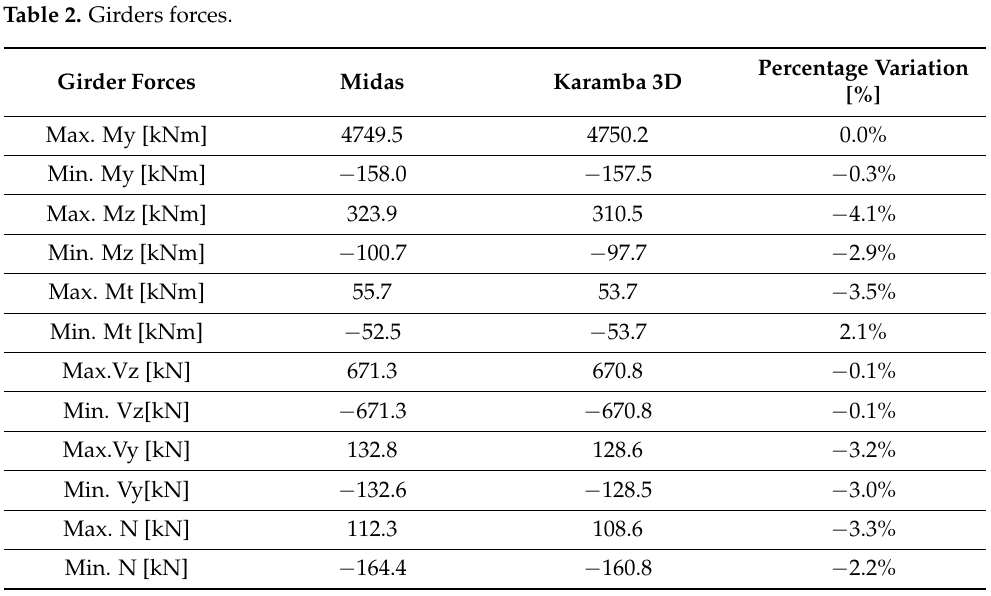
Table 2. Girders forces.